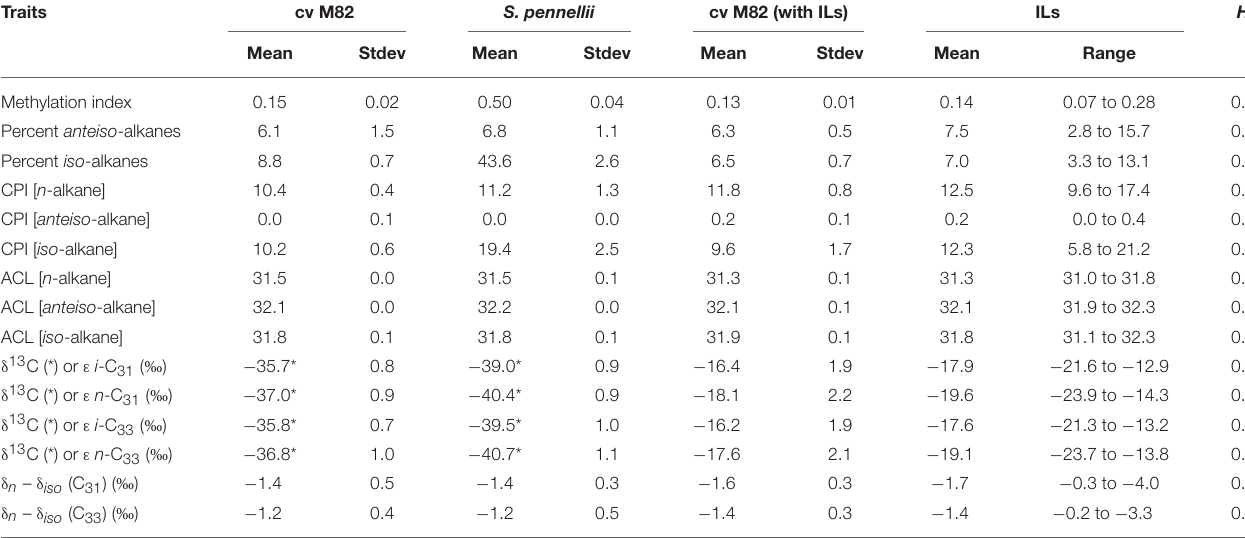
TABLE 1 | Leaf wax traits for S. lycopersicum , S. pennellii , and ILs. Traits cv M82 S. pennellii cv M82 (with ILs) ILs H 2 Mean Stdev Mean Stdev Mean Stdev Mean Range Methylation index 0.15